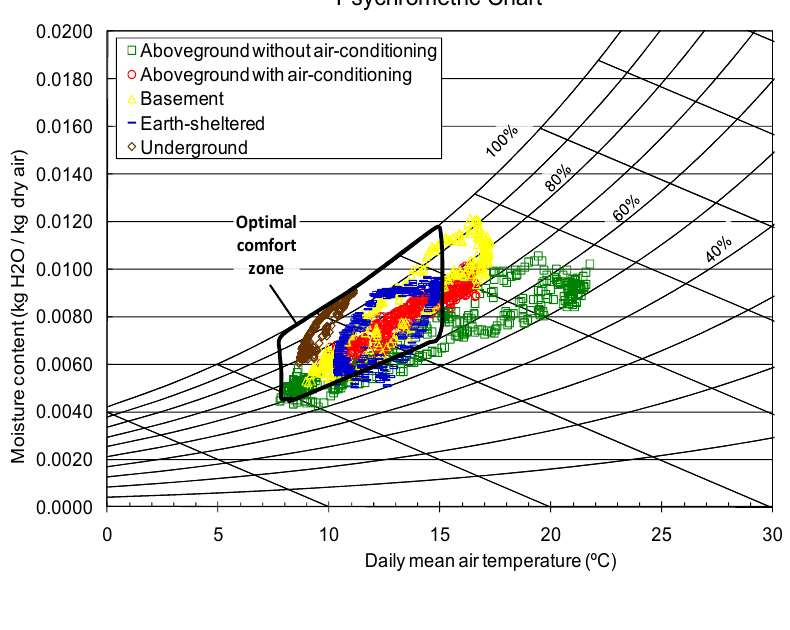
Figure 9. Indoor hygrothermal conditions for the different constructive solutions. Representation of daily average values for the average